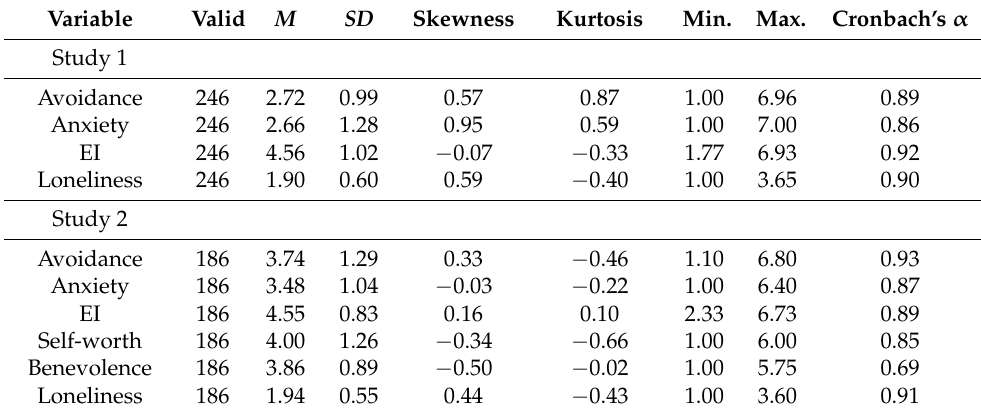
Table 2. Descriptive statistics.